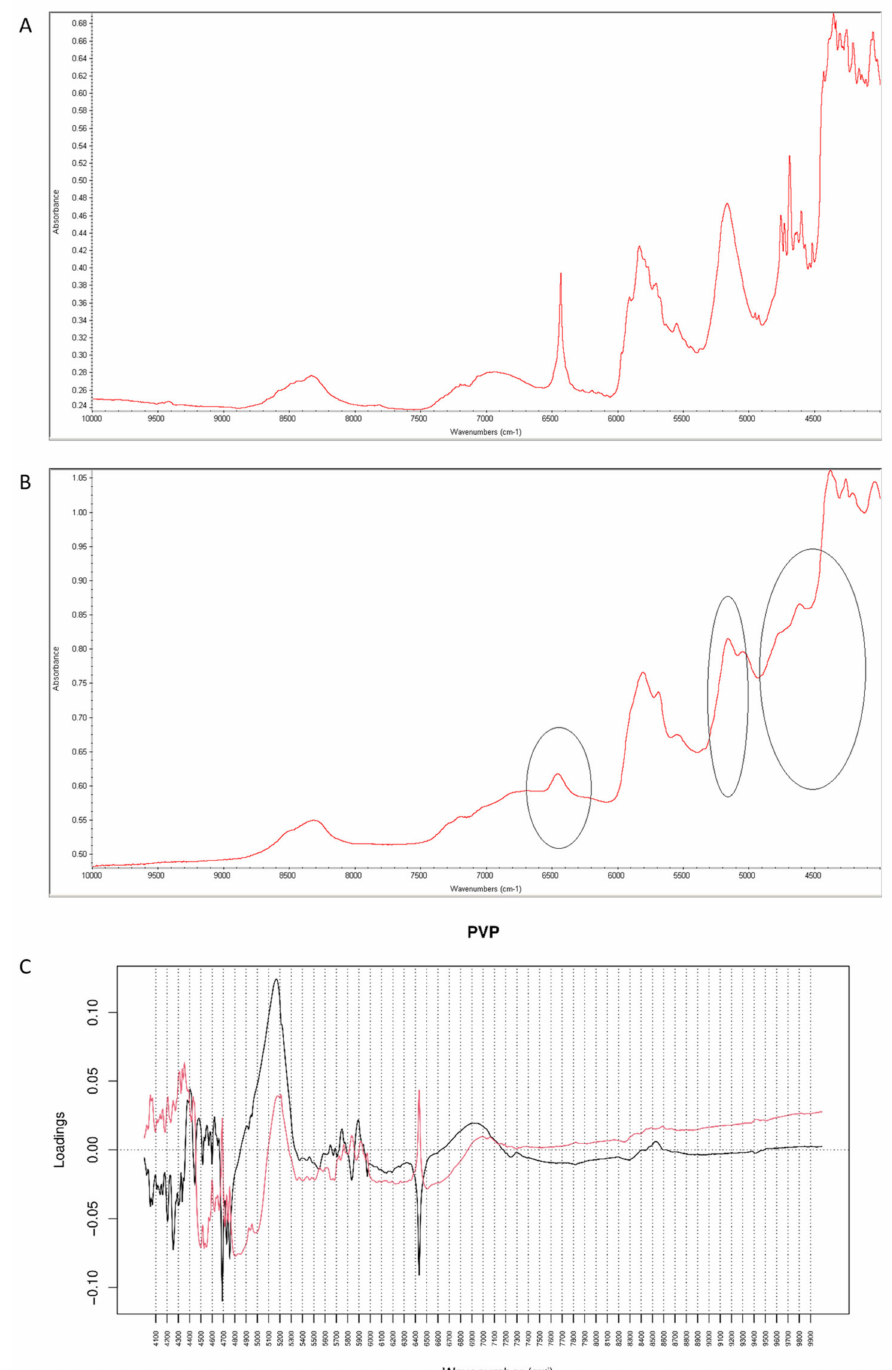
Figure 19. ( A – C ) Vildagliptin and polyvinylpirrolidone (PVP): NIR spectra of no stressed mixture ( A ), stressed mixture ( B ) and PCA loadings of the spectra ( C ); PC1 loadings are marked black while PC2 loadings are marked red; most visible differences in the spectrum of the stressed mixture are indicated with